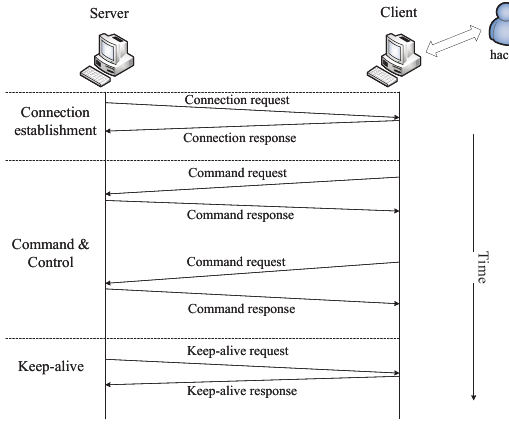
Figure 1. Whole communication of